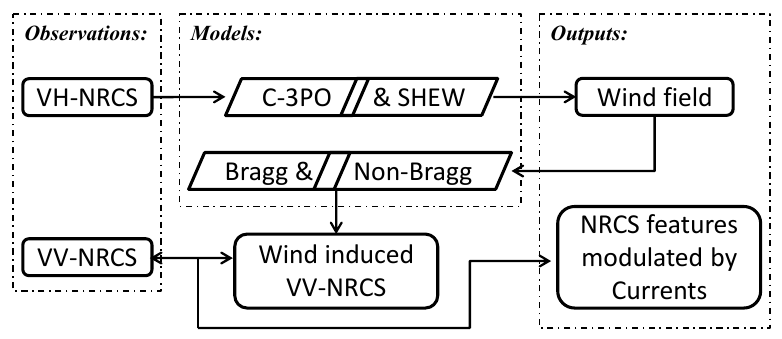
Figure 4. Flow chart for wind field retrieval and the backscatter features of surface currents.